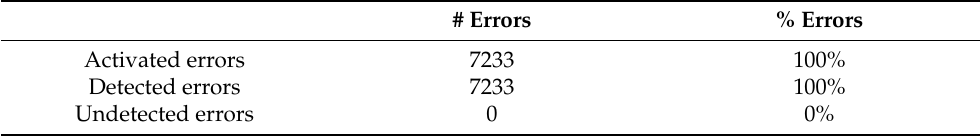
Figure 20. Percentage of errors caused by register file entries and PC register. Table 3. Simulation results of fault injection.